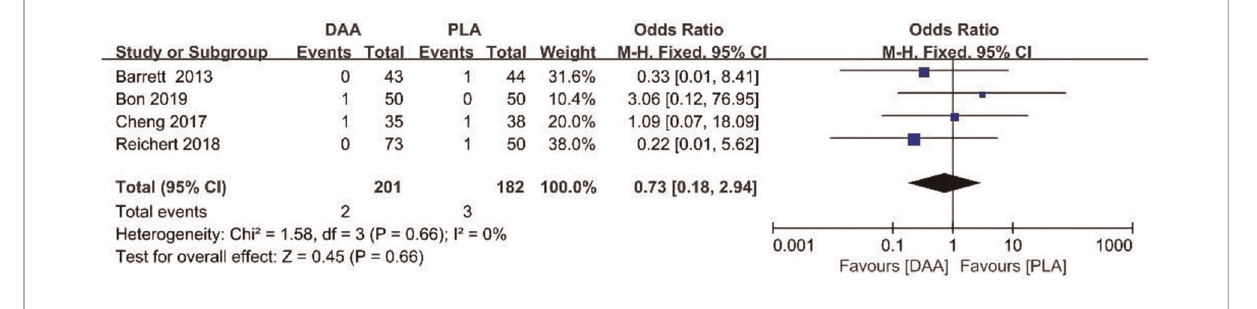
FIGURE 8 Dislocation rate outcome forest plot analyses.